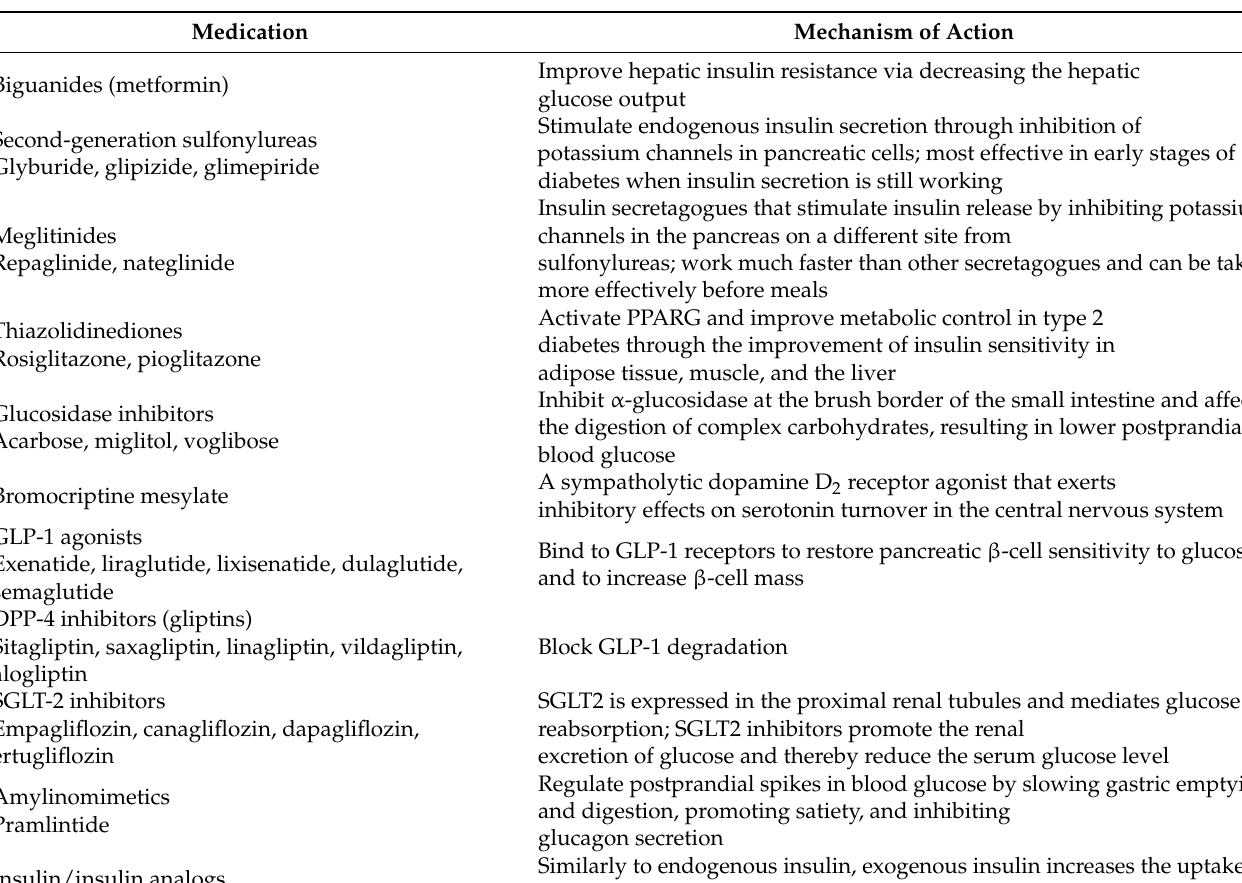
Table 2. List of current drugs that are used in the management of diabetes